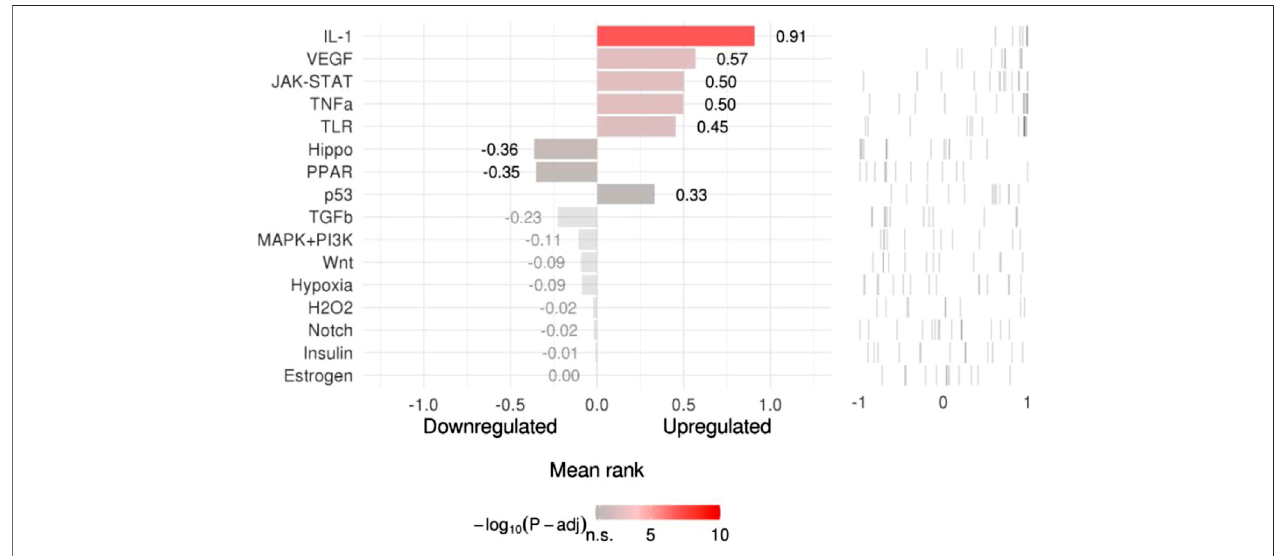
FIGURE 8 | Pathway activity